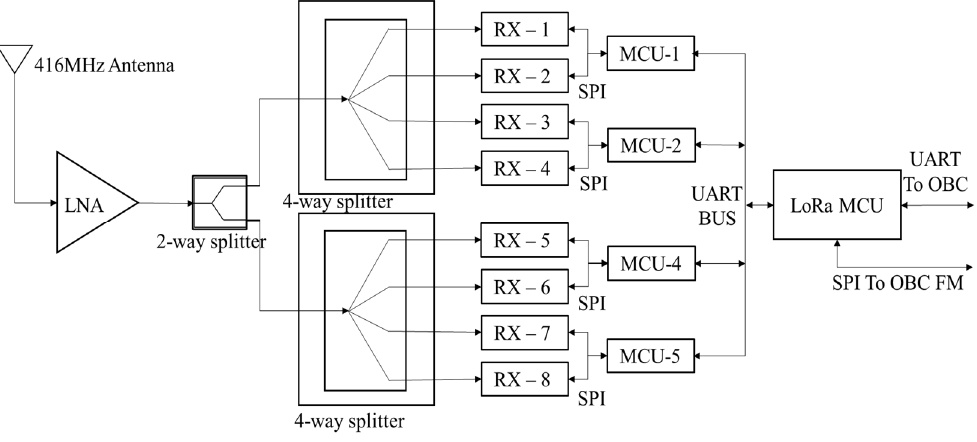
Figure 5. SIoT payload block diagram.